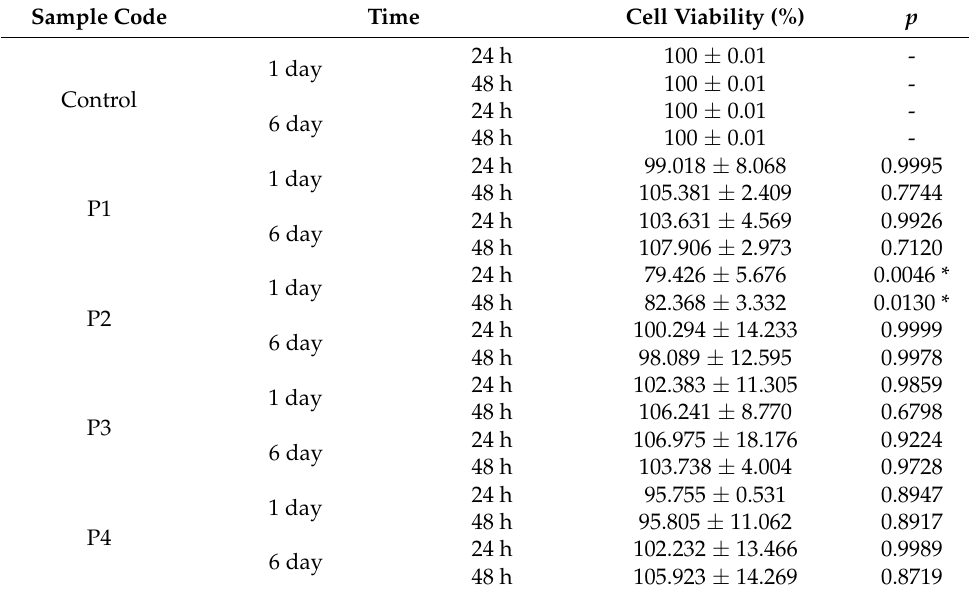
Table 5. The effect of P1 to P4 extracts on L929 cell viability after 1 day and 6 days of treatment. Sample